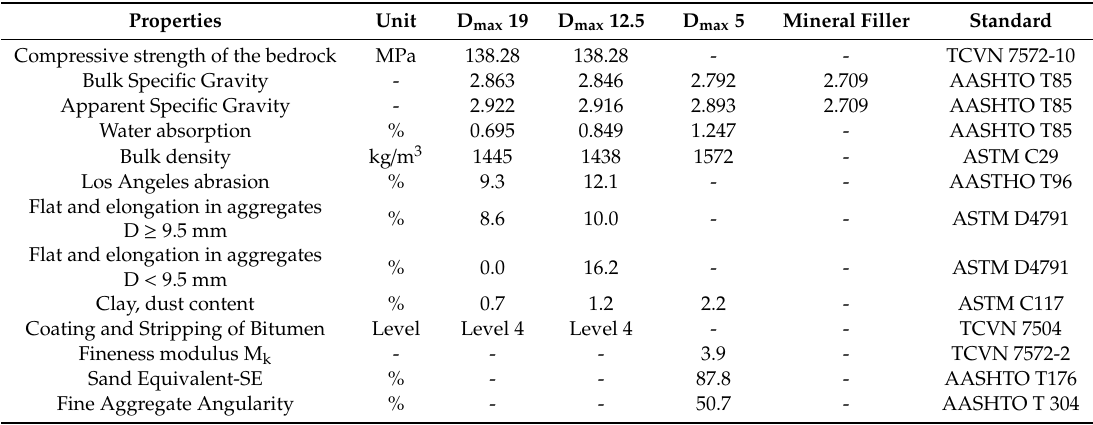
Table 1. Physical properties of coarse and fine aggregates and mineral filler.